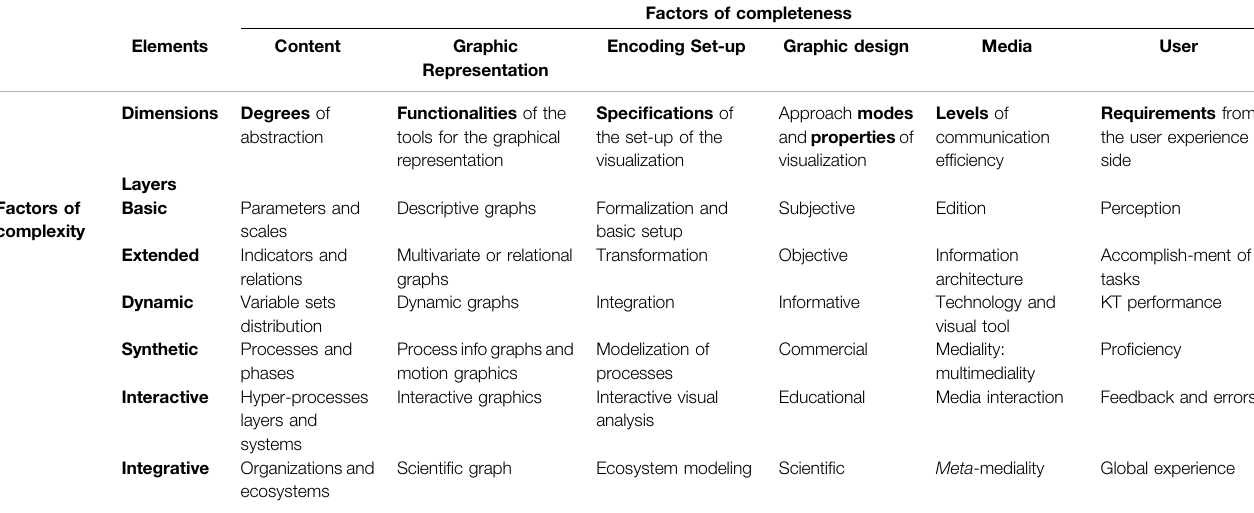
TABLE 2 | Dimensional taxonomy of data visualization: factors of completeness and factors of complexity.